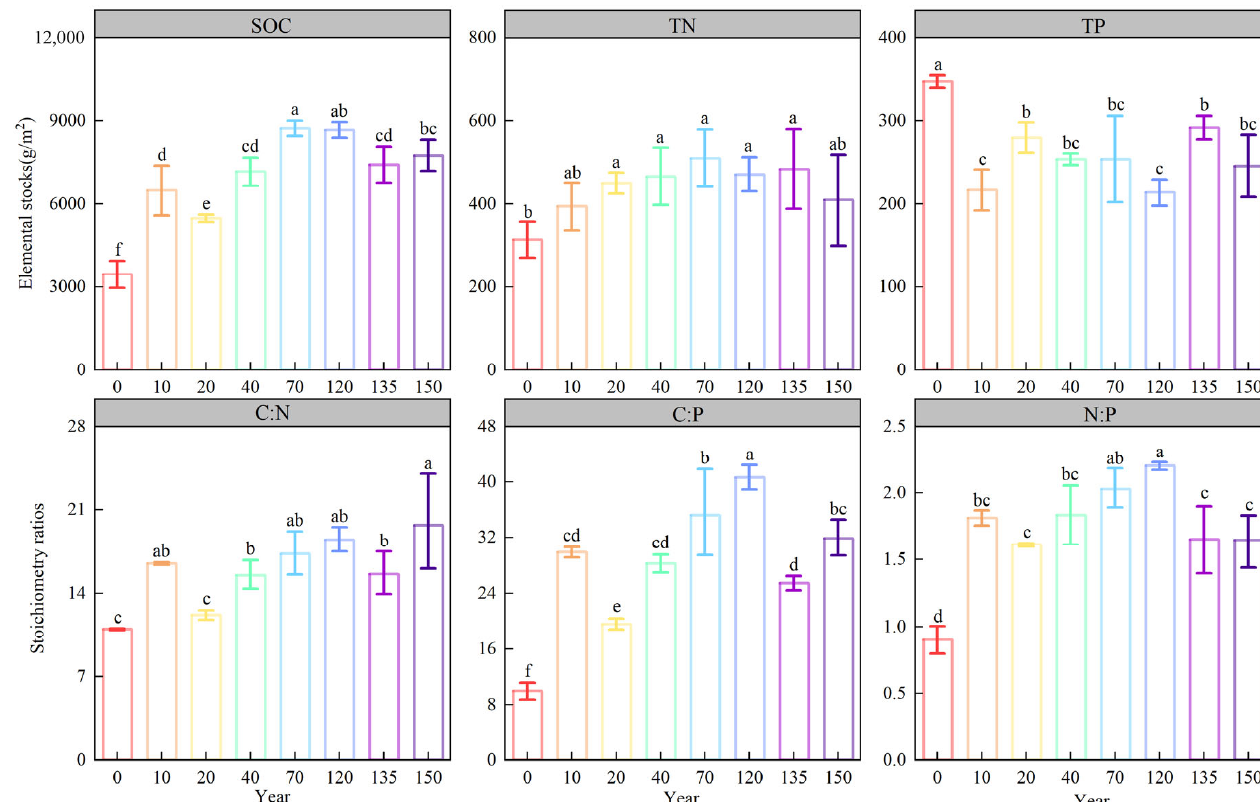
Figure 4. Soil C:N:P stoichiometry characteristics among the different periods. Different lowercase letters (a, b, c, d, e, and f) indicate significant differences ( p < 0.05) within each variable among the different restoration periods.